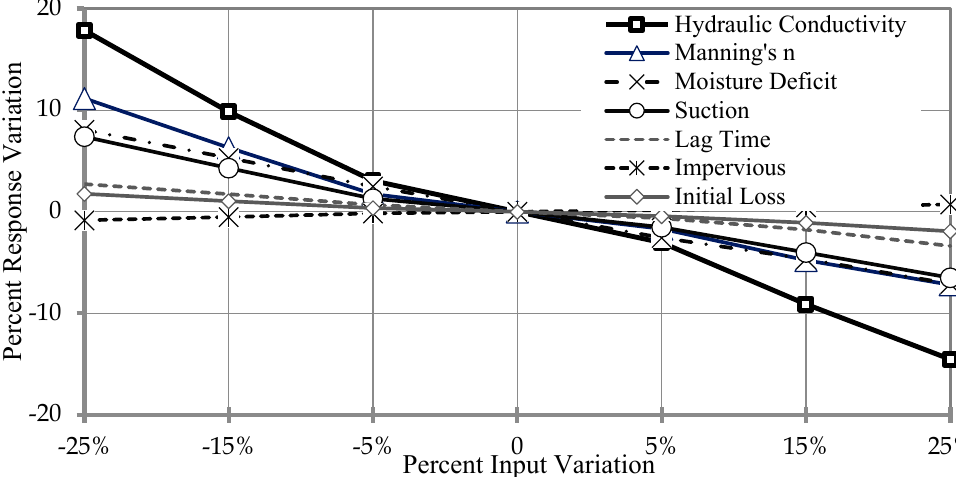
Figure 7. Sensitivity of several input parameters to runoff amount for Green and Ampt method.